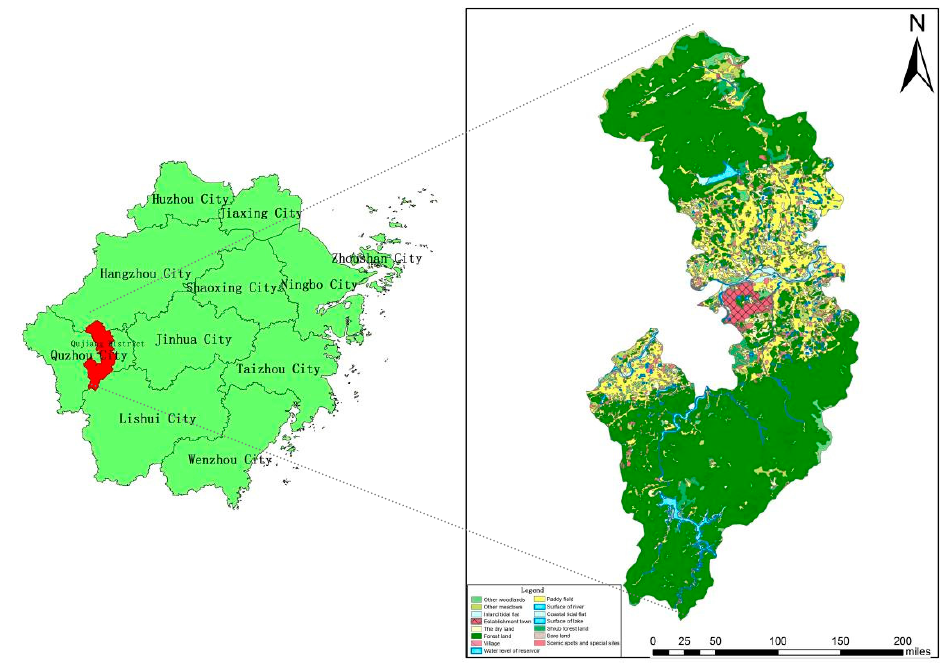
Figure 1. Administrative divisions of Qujiang District.